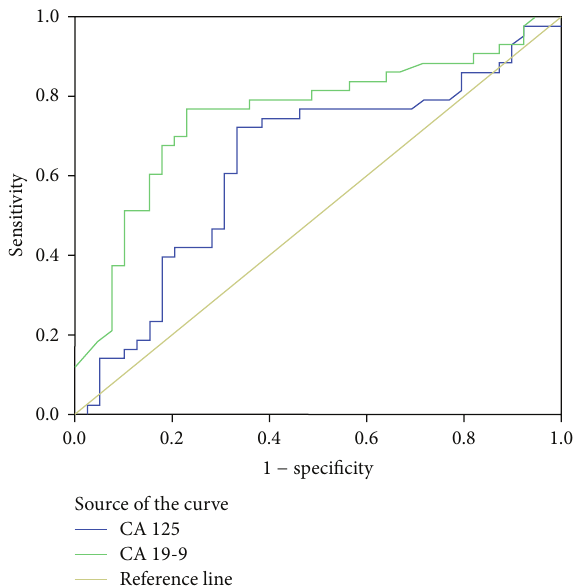
Figure 2: ROC curve for CA-19.9 and CA-125. The area under the curve (AUC) for CA19-9 is 75.4 (95% CI: 64.5–86.3). The AUC for CA-125 is 63.3 (95% CI: